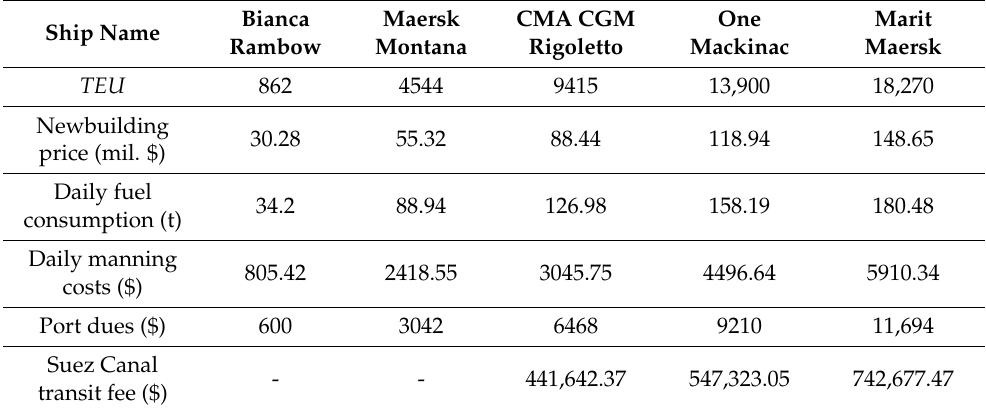
Table 2. Data used for calculating costs of the conventional